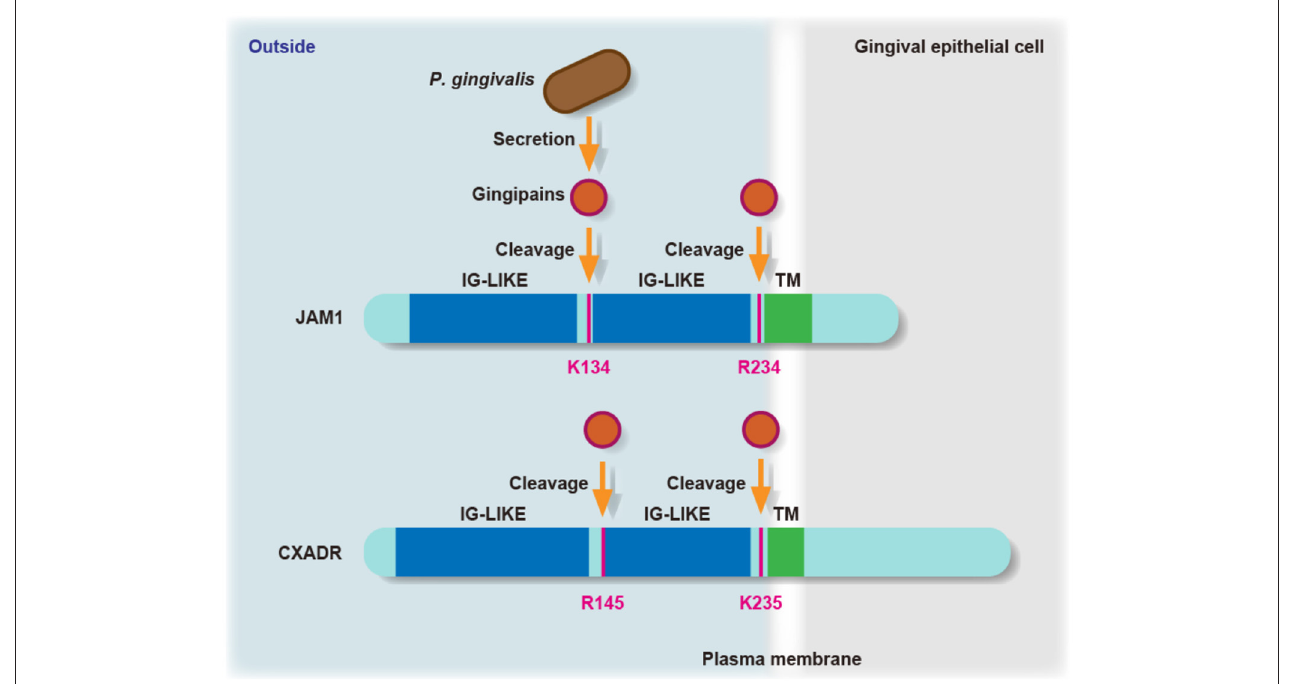
FIGURE 1 | The residues involved in degradation of JAM1 and CXADR by P. gingivalis gingipains. Schematic view of the JAM1 and CXADR structure in gingival epithelial cells. The K134 and R234 residues of JAM1, and the R145 and K235 residues of CXADR are involved in degradation by P. gingivalis gingipains in gingival epithelial cells. IG-LIKE, immunoglobulin-like domain (blue); TM, transmembrane domain